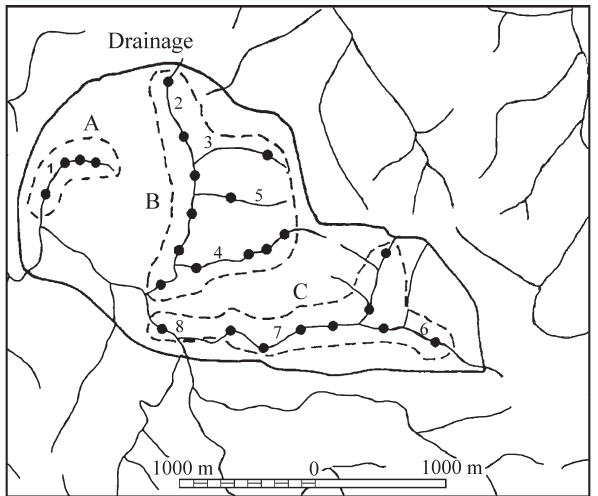
Figure 1 - Map of the study site at Parque Estadual de Carlos Botelho, state of São Paulo, southeastern Brazil. The sample drainage for Hydromedusa maximiliani is showed as a heavy line with numbers 1-8 in- dicating rivers and streams surveyed. Dotted lines show the three sample sites (A, B, C) defined according to the spatial hierarchy of the main rivers and their tributaries Dots indicate individual collection